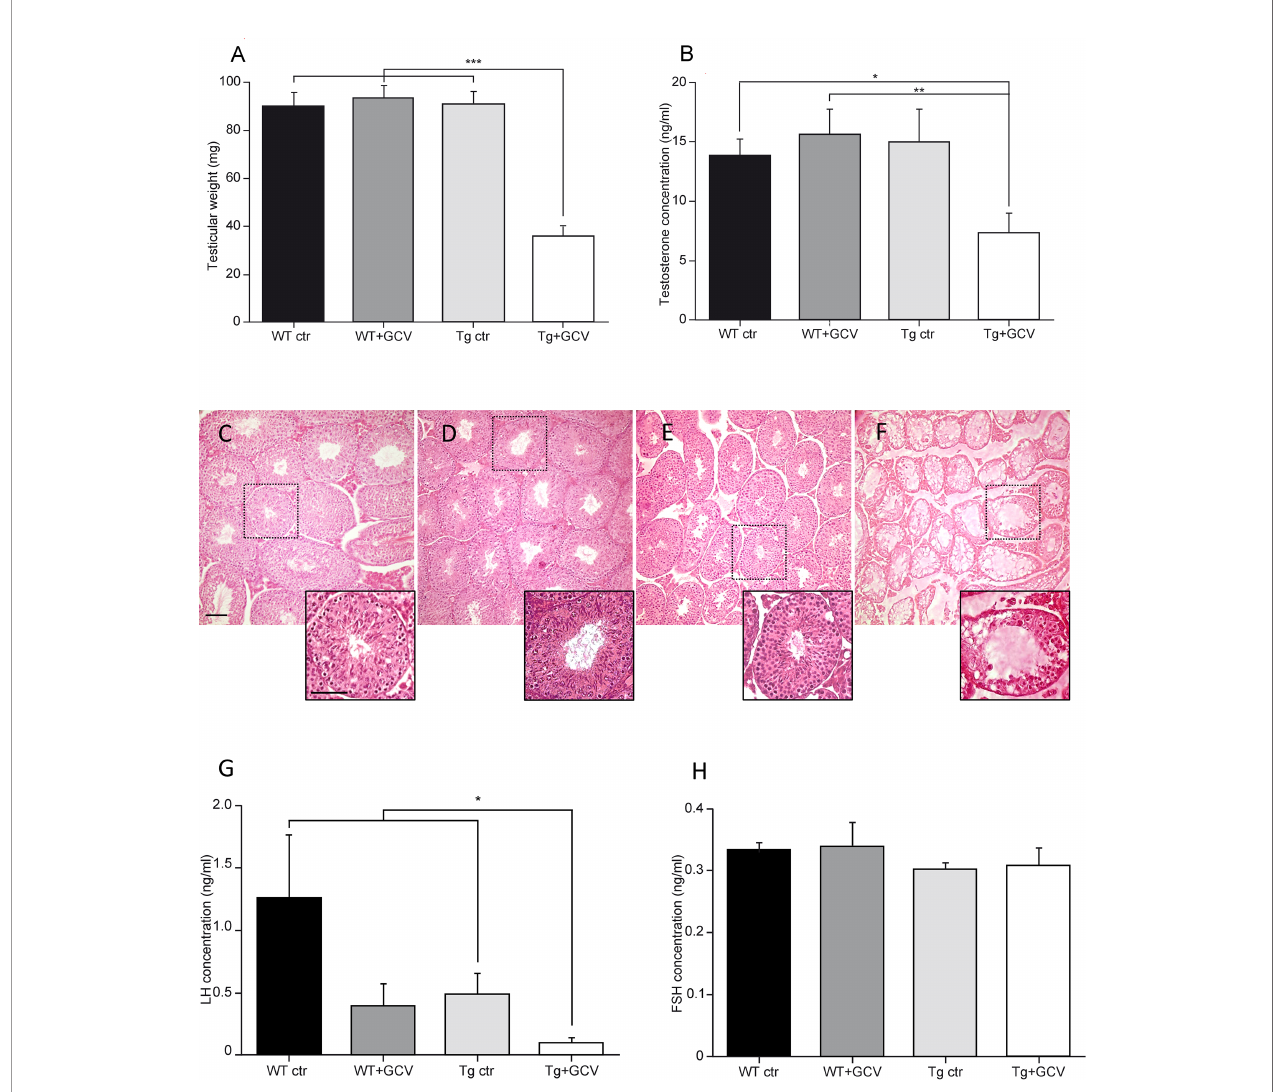
FIGURE 4 | Alteration of gonadal functions after central GCV administration in Tg mice. Tg+GCV male mice display decreased testicular weight (A) and plasma testosterone concentrations after hCG (human chorionic gonadotropin) injection (B) . Testicular histology of WT ctr (C) , WT+GCV (D) , Tg ctr (E) and Tg+GCV (F) male mice revealed alterations and vacuolization of seminiferous tubules after central GCV administration in Tg mice, scale bars, 50 µm Insets show a higher magni fi cation image of a single seminiferous tube for each group of mice. Scale bar, 200 µm. Tg+GCV male mice display decreased serum LH concentration (G) while serum FSH concentration is not affected by the treatment (H) . Data are expressed as the mean ± SEM, n ≥ 3 for each group. *p<0.05, **p<0.01,